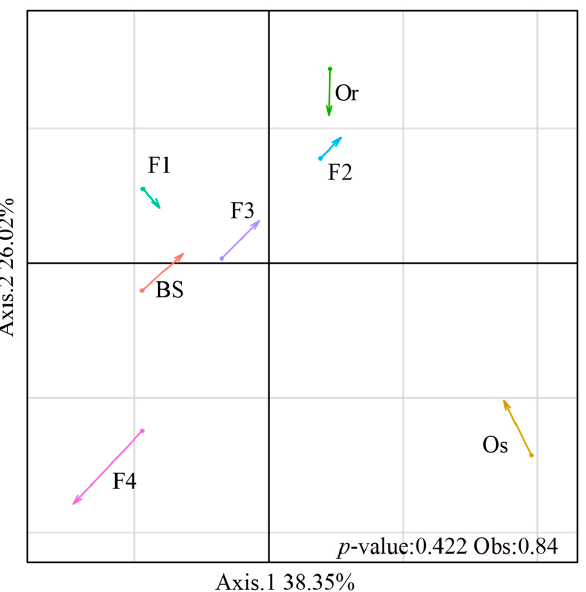
Figure 3. Co-inertia analysis of bacterial and fungal communities in bulk soil (BS) and the rhizo- spheres of the female parent Oryza rufipogon (Or) wild rice; male parent Oryza sativa (Os) cultivated rice; hybrid generation (F1); and the generations F2, F3 and F4 obtained by self-crossing. The arrows represent the co-variation of both communities within the generations (the shorter the arrow, the higher the covariance between bacterial and fungal community). The arrows origins represent the bacterial communities and the arrow heads represent the positions of the fungal communities in the co-inertia space.